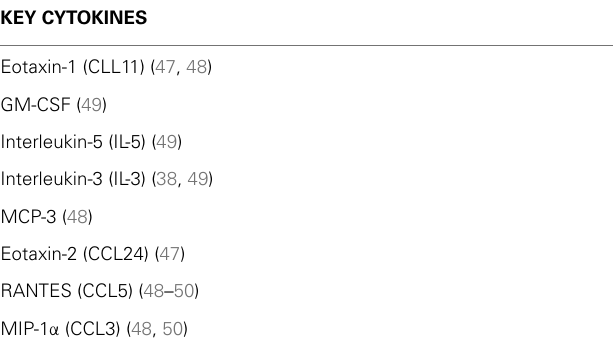
Table 1 | Key cytokines involved in eosinophil recruitment . KEY